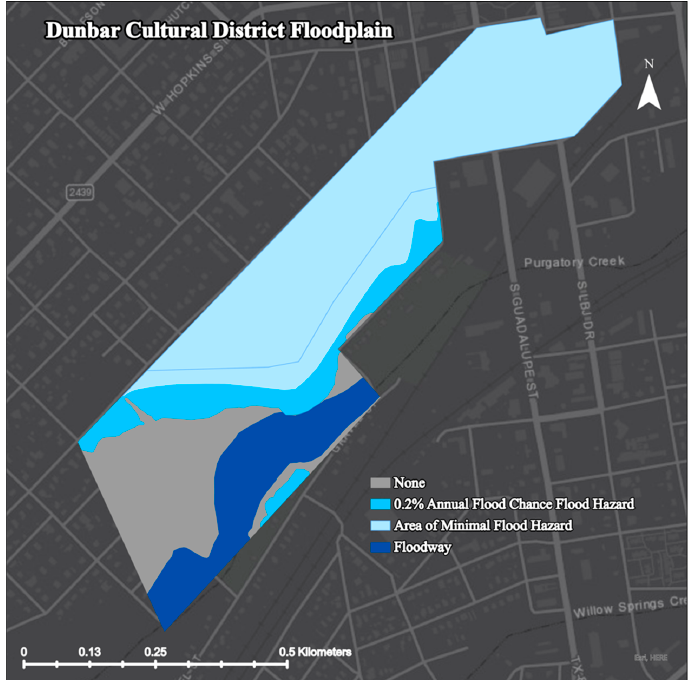
Figure A3 . Dunbar Cultural District Floodplain. Dunbar Cultural District floodplain map. Data for this map were obtained from the Federal Emergency Management Agency and Esri basemaps.